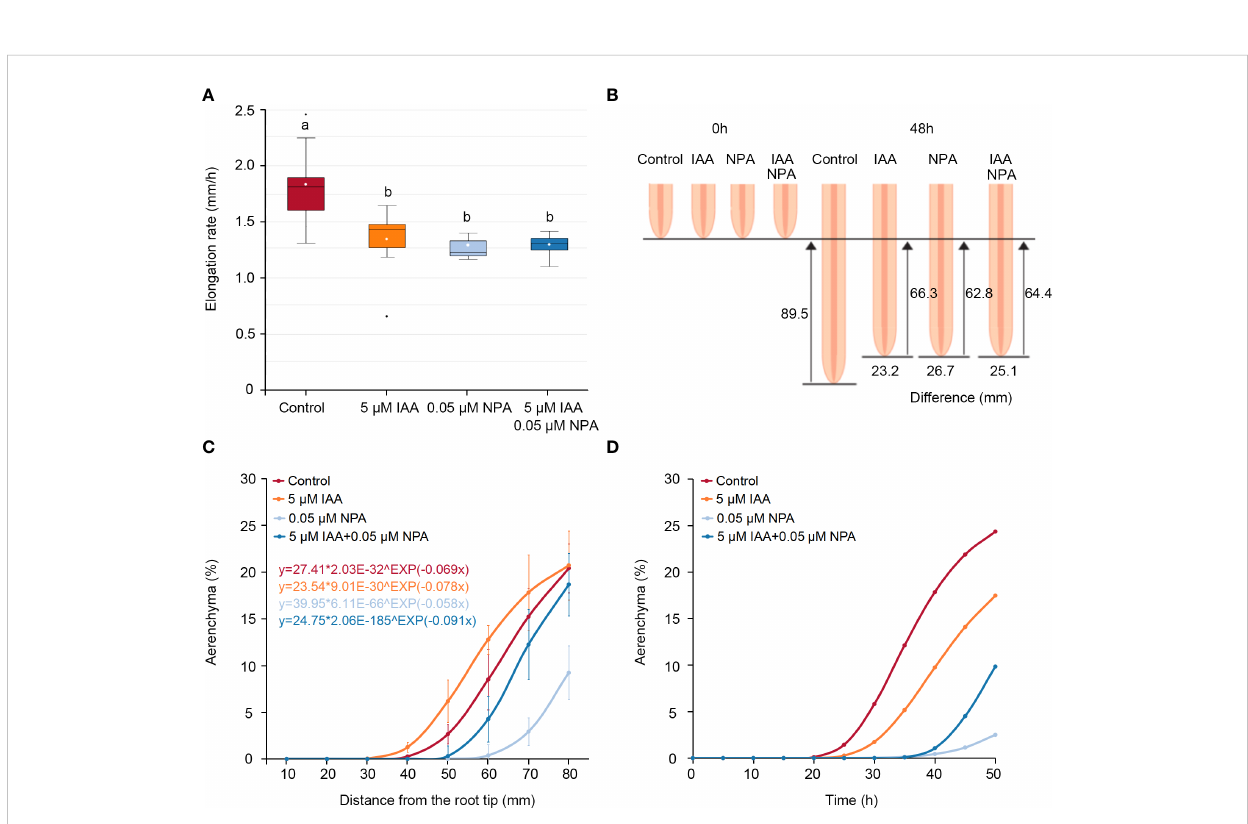
FIGURE 2 Age-dependent aerenchyma formation in the third nodal roots of Z. nicaraguensis under aerated conditions with IAA and/or NPA treatments. (A) Elongation rate of the nodal roots of Z. nicaraguensis seedlings grown under aerated conditions with IAA and/or NPA treatments. Boxplots show the median (horizontal lines), 25 th to 75 th percentiles (edge of the boxes), minimum to maximum (edge of the whiskers), and mean values (dots in the boxes) ( n = 6). Signi fi cant differences among the treatments are denoted with different lowercase letters ( p < 0.05, one-way ANOVA, followed by LSD test for multiple comparisons). (B) Schematic diagram of root elongation and differences in the distances from the root tips among the treatments at 0 h and 48 h. (C) The Gompertz curve is fi tted for the percentage of aerenchyma formed. The obtained equations for each of the treatments are indicated above the graph. (D) Age-dependent aerenchyma formed was predicted by the equations obtained from Gompertz curve fi ttings. The percentage of aerenchyma formed at each time point was calculated using the distance from the root tips at each time point as the explanatory variable, which was calculated from the elongation rate under each treatment (A) .